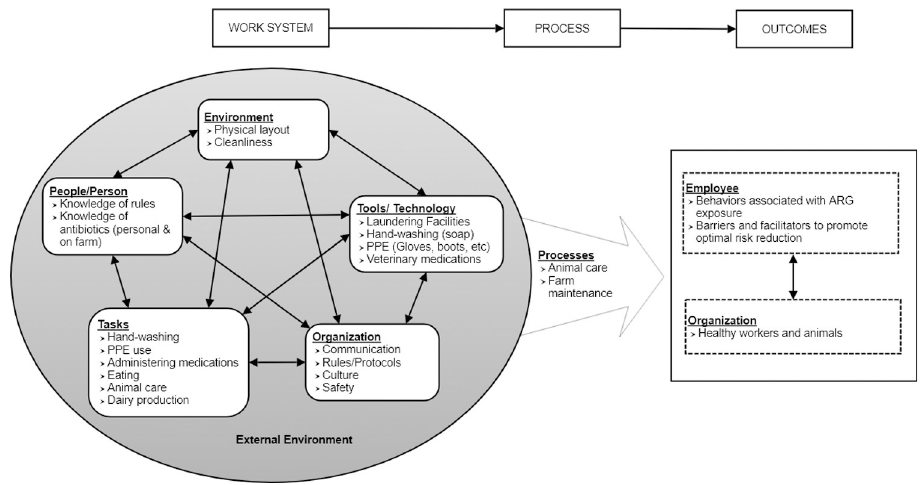
Fig 1. Systems Engineering in Patient Safety (SEIPS) model adapted for use on dairy farms. Headers represent the original SEIPS categories and bullet points represent how these categories related to dairy